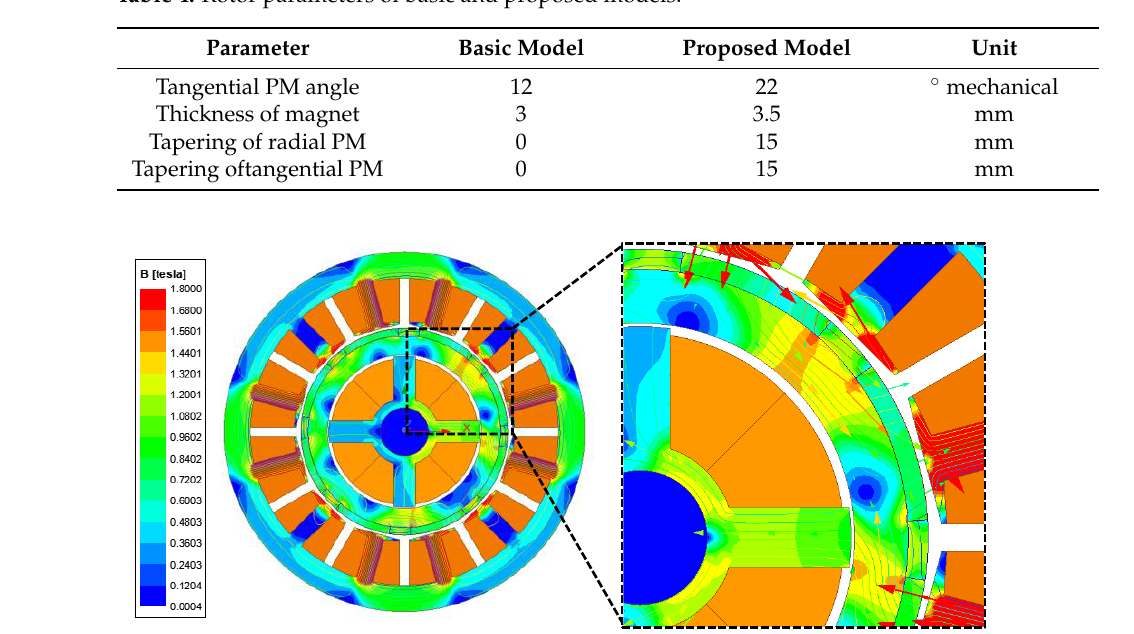
Figure 24. 2D cross section of integrated magnetic bearing: ( a ) Basic model; ( b ) proposed model. Table 4. Rotor parameters of basic and proposed models.